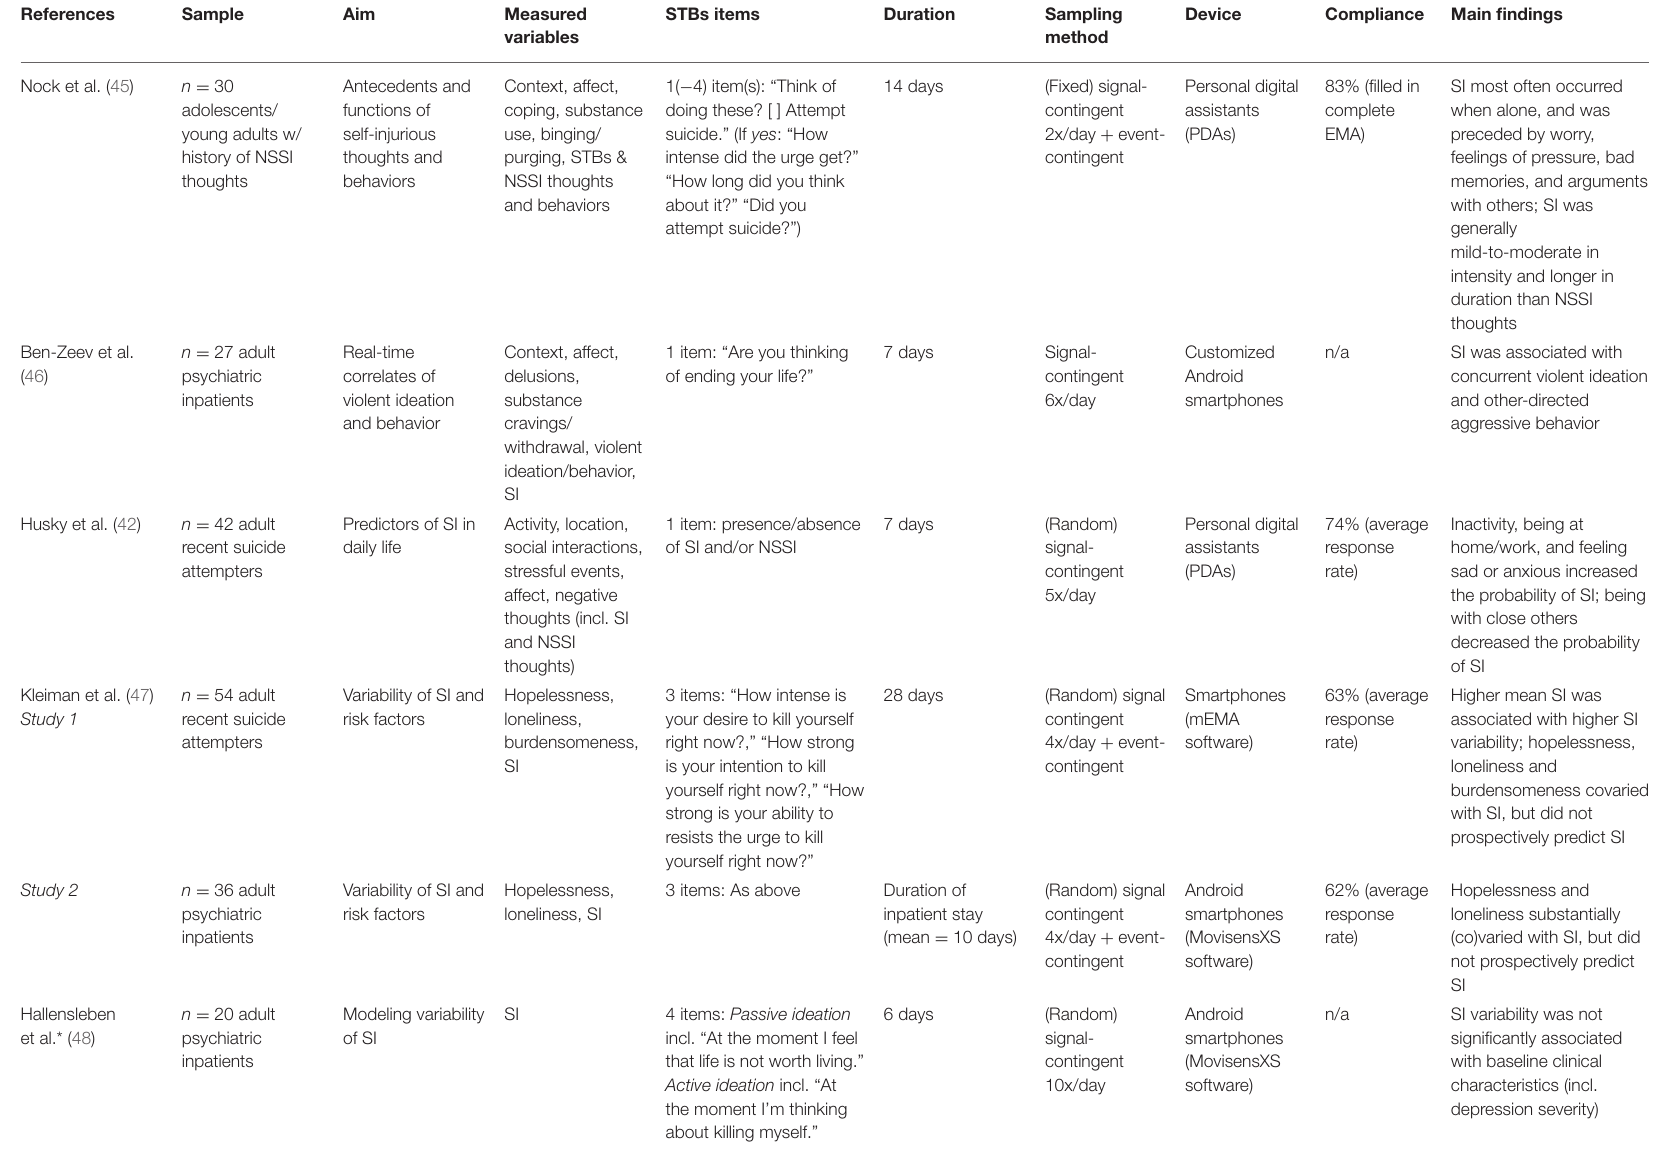
TABLE 1 | Overview of manuscripts reporting on studies using EMA to assess suicidal thoughts and behaviors